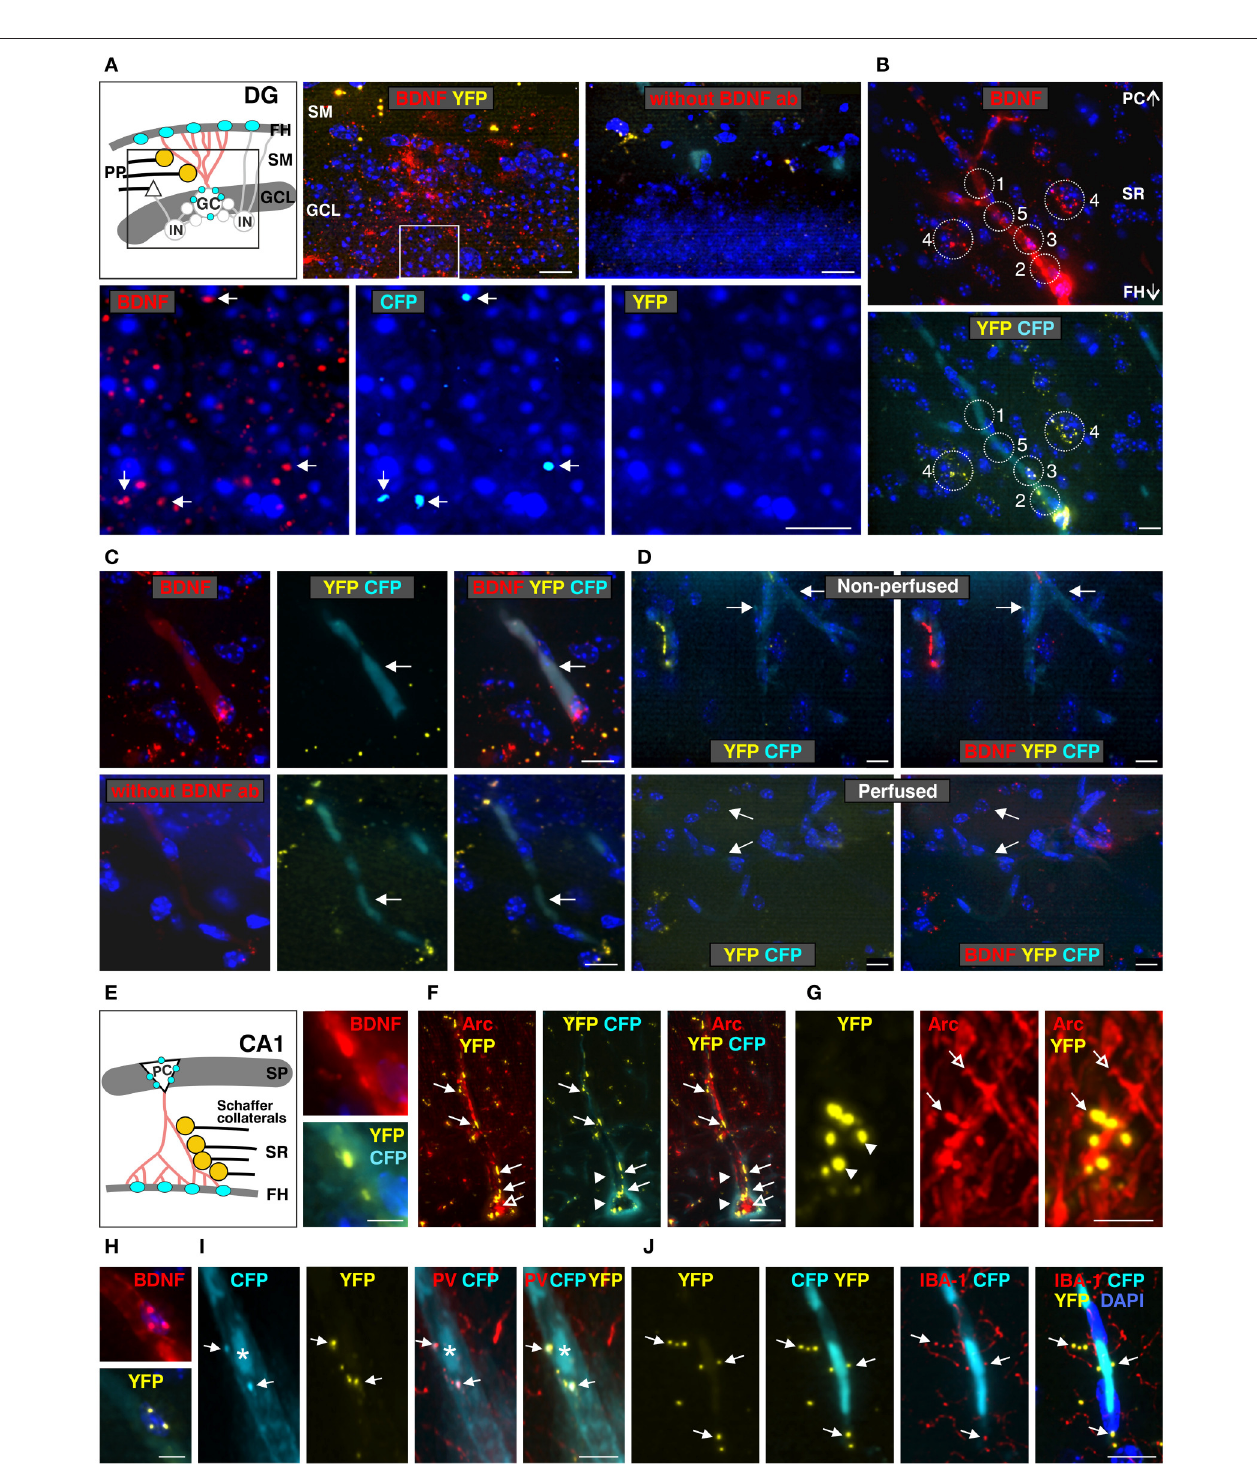
FIGURE 5 | Co-localization of anti-BDNF antibody with Bdnf exon-IV-CFP and Bdnf exon-VI-YFP in the dentate gyrus (DG, A ) and the CA1 region (B–J) (see Supplementary Video 1 ). (A) Top panel: schematic view of the granule cell layer (GCL) and the stratum moleculare (SM) of the DG. Low-power examination depicts BDNF-IR within the GCL of the DG (boxed area in sketch). No labeling was seen when anti-BDNF was omitted. Bottom panel: high-power examination from boxed area shows BDNF to co-localize with a few CFP-positive dots (arrows) but not with YFP-positive dots. Scale bars: 100 µ m. (B) BDNF-IR in 5 different characteristic regions at the level of the stratum radiatum (SR) co-localized with Bdnf exon-VI-YFP and Bdnf exon-IV-CFP, see also Supplementary Figure 4 . Scale bars: 100 µ m. (C) BDNF-IR in blood vessel (arrows) co-localized with Bdnf exon-IV-CFP but not with Bdnf exon-VI-YFP. No BDNF-IR is observed when BDNF antibody is